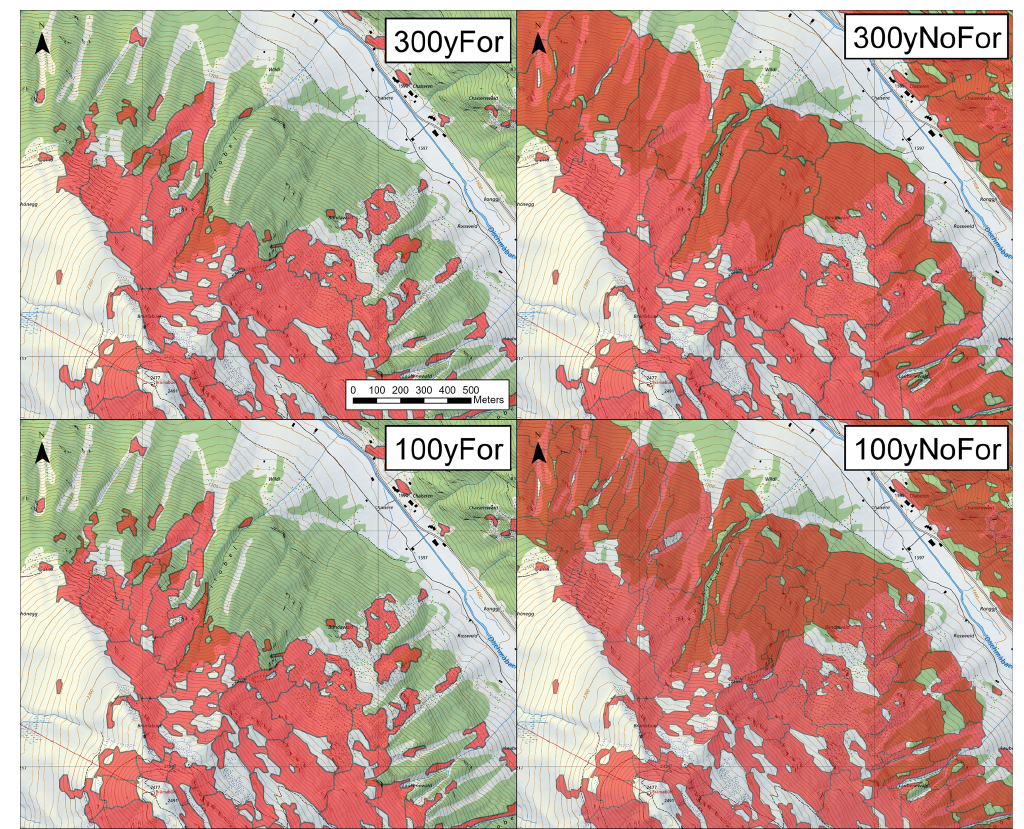
Figure 5. PRA delineation at the Duchli slope at the beginning of the Dischma valley close to Davos for the two rare scenarios (300 and 100 years) with (For) and without (NoFor) taking the protective effects of the forest into account (map source: Swiss Federal Office of Topography).